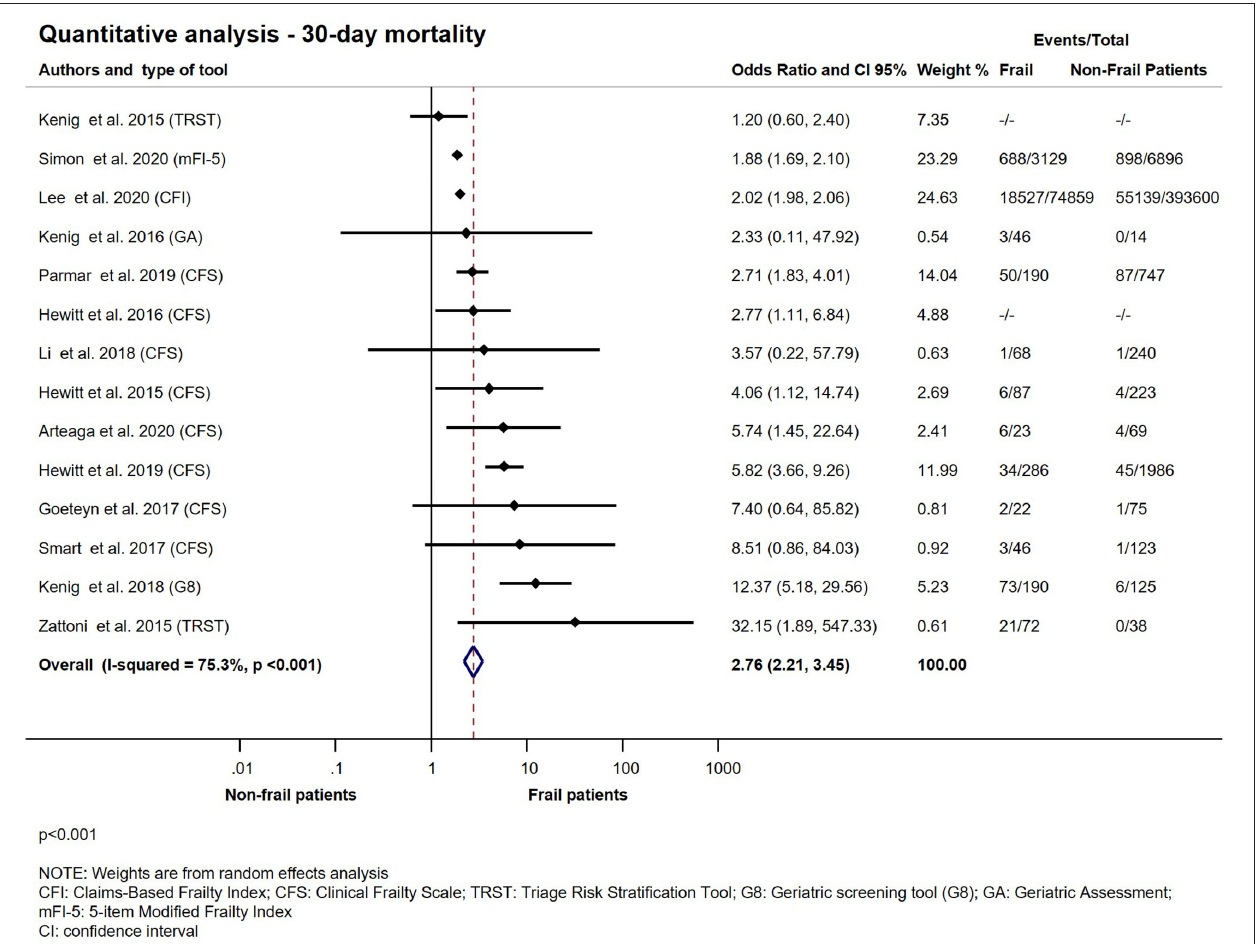
FIGURE 2 | Quantitative analysis − 30-day mortality for emergency surgical patients living with frailty compared to non-frail patients. For patients living with frailty, the overall OR of 30-day mortality was 2.76 (2.21–3.45). From the study of Hewitt et al. (23) and Kenig et al. (26) crude OR was pooled with the ORs calculated from raw data. Note substantial